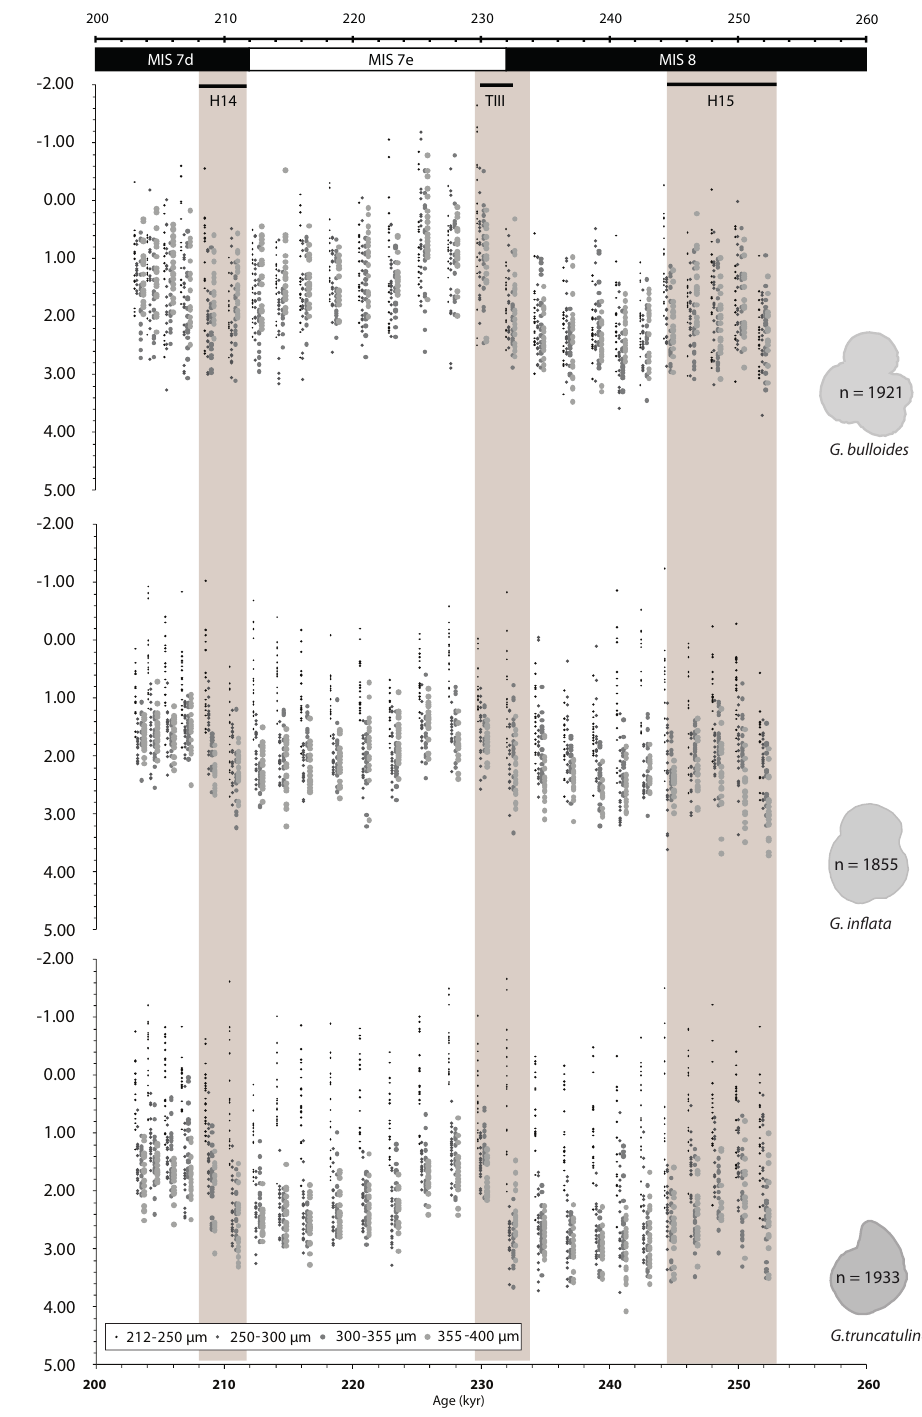
Figure 4. Single-specimen oxygen isotope values. Raw δ 18 O values; symbol size denotes size fraction. For convenience, the data points are offset from one another. Shaded regions represent periods where ice-rafted debris is present within the core; however, this envelope is larger than the actual duration of a Heinrich event, as it is difficult to constrain the precise date of such “old”